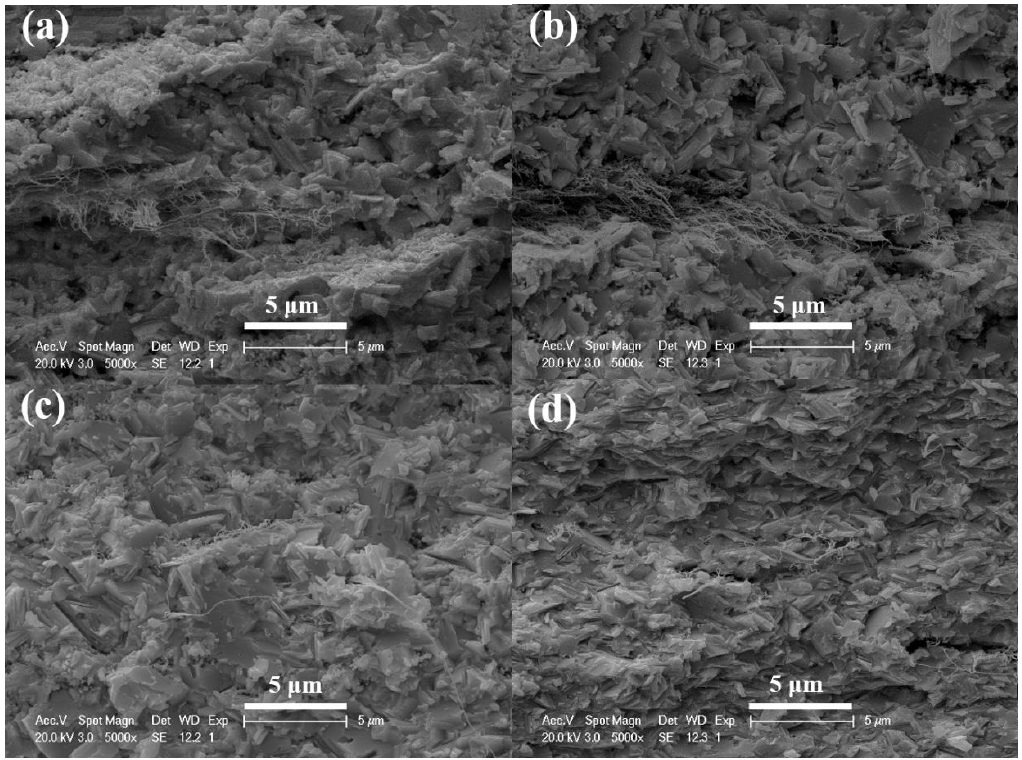
Figure 4. Fracture surface SEM images of ( a ) CNT / BT-PS-598, ( b ) CNT / BT-PS-648, ( c ) CNT / BT-PS-698, and ( d ) CNT / BT-HP-648.